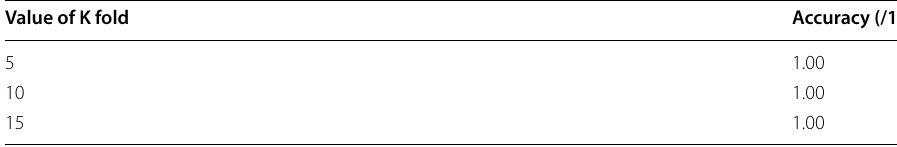
Table 5 DTREE model accuracy result